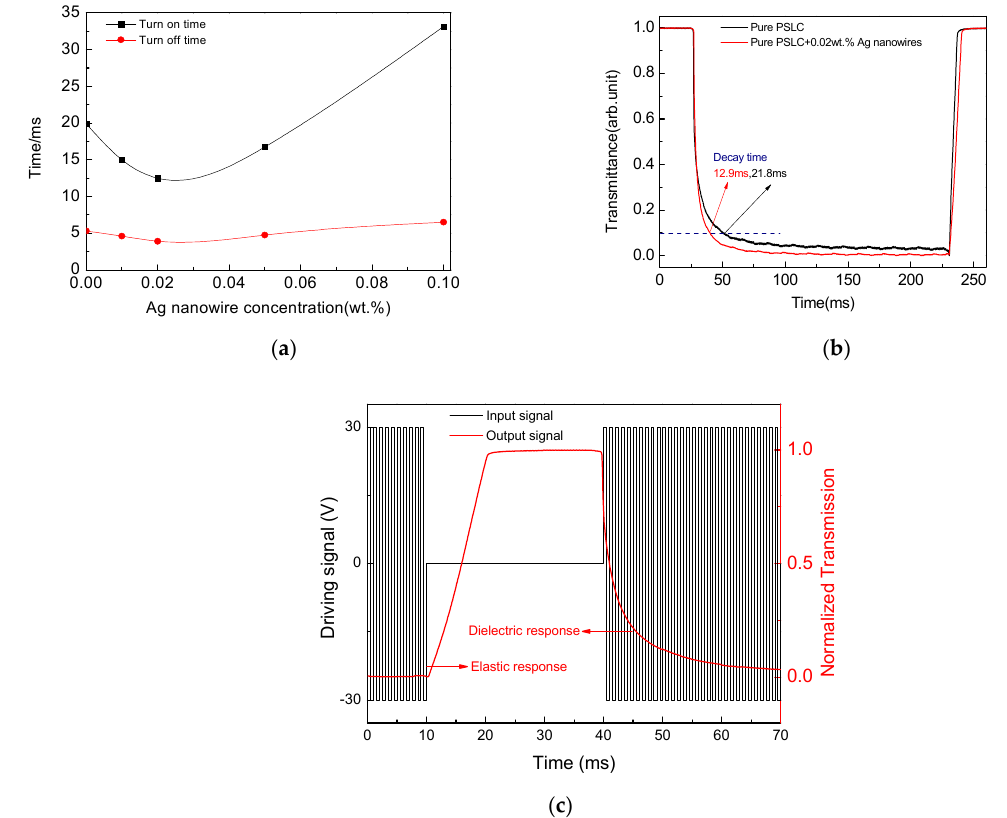
Figure 6. Response time of the Ag nanowire doped PSLC according to the Ag nanowire concentration: ( a ) response time according to the Ag nanowire concentration; ( b ) comparison of response time of pure PSLC and 0.02 wt.% Ag nanowire doped PSLC; and ( c ) input signal and output signal of PSLC with 0.02 wt.% Ag nanowire.